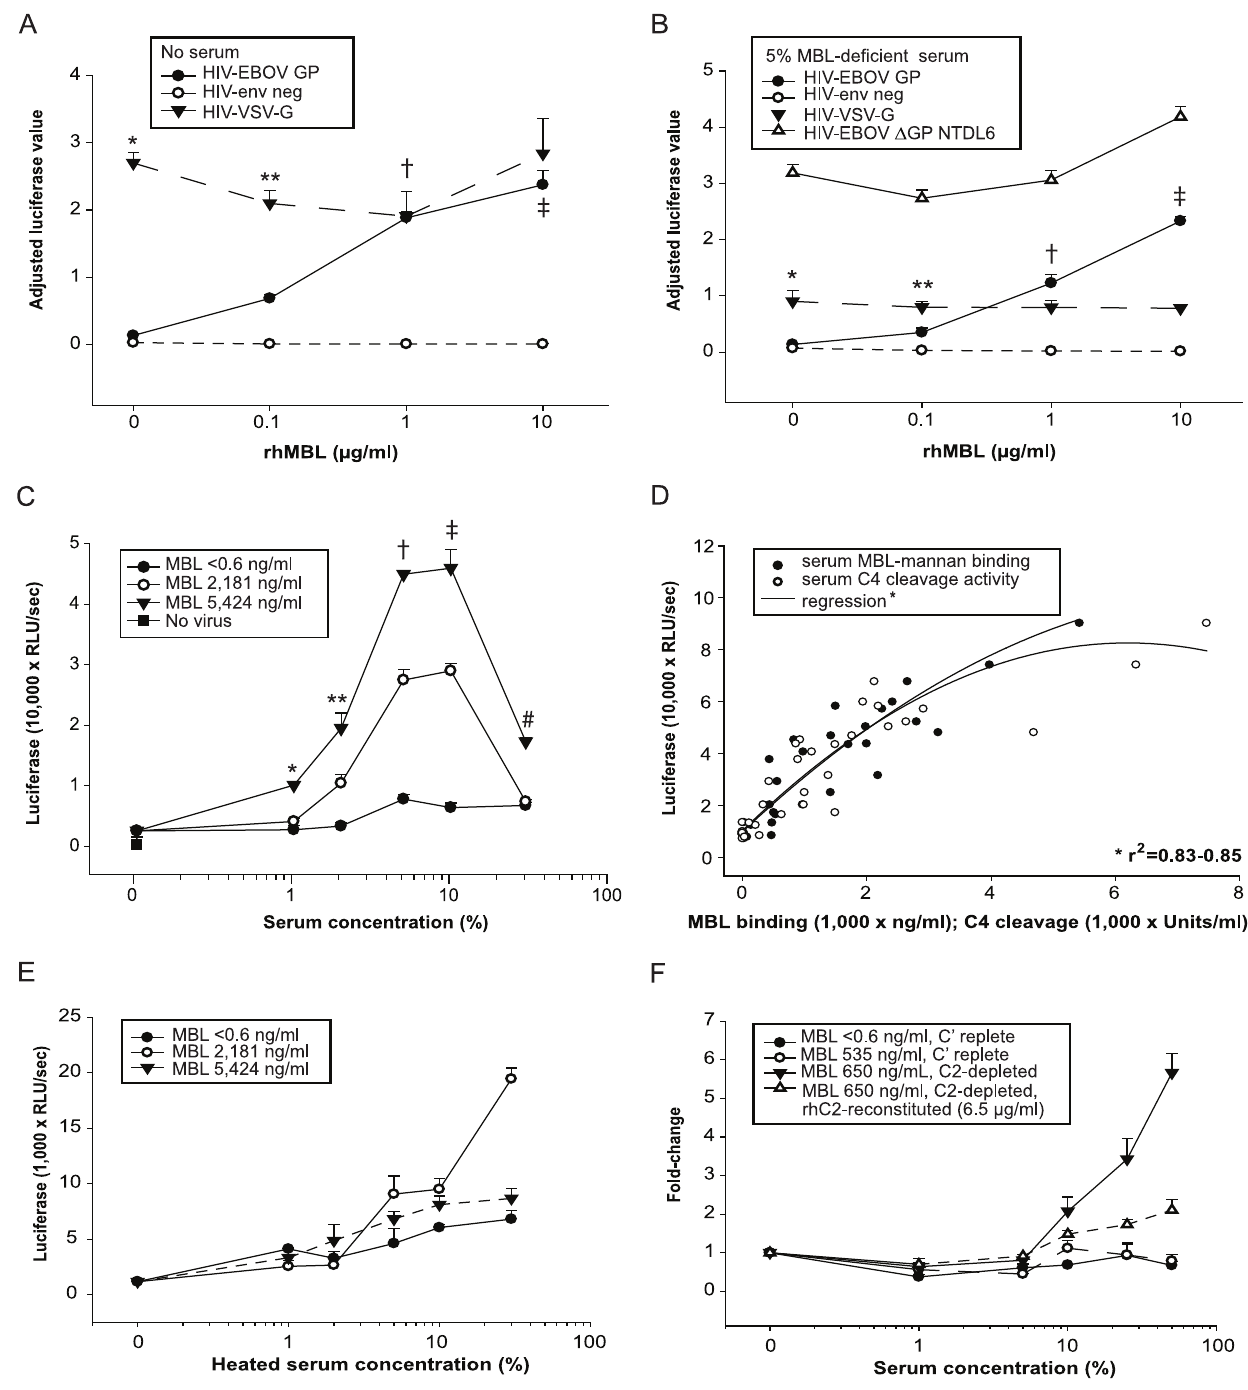
Figure 1. MBL enhances HIV-EBOV GP infection of HEK293F cells in low complement conditions. We used luciferase-encoding HIV-EBOV- GP virion-like particles to infect 5 6 10 3 adherent HEK293F cells. Viruses (350 pg p24/100 m l) were preincubated with physiological concentrations of rhMBL (0.1–10 m g/ml) in (A) DMEM or (B) MBL-deficient ( , 0.6 ng/ml) 5% human serum for 1 hour at 37 u C. We analyzed infection rates after 40 hours. Luciferase absorbance values were adjusted for cell viability by normalizing to alamarBlue fluorescence units (resazurin reduction assay) and results are expressed as Adjusted Luciferase Values. Significant differences are shown. * and ** p , 0.05 (HIV-VSV-G vs both other virions at 0 and 0.1 m g/ml supplemental rhMBL, respectively), { and { p , 0.05 (HIV- envelope negative vs both other virions at 1 and 10 m g/ml supplemental rhMBL, respectively). Also shown in (B) is the reduced capacity of rhMBL to enhance infection by HIV-EBOV- D GP NTDL6 (mutated GP lacks 217 amino acids in the heavily glycosylated mucin-rich region) compared with that for HIV-EBOV GP, which contains intact mucin-rich regions (1.3- vs 17.2 2 fold enhancement, respectively, p , 0.001). Experiments were performed twice in quadruplicate. (C) We preincubated HIV-EBOV GP with serial dilutions of serum from three individuals with undetectable ( , 0.6 ng/ml; LYPB/LYPB), intermediate (2,181 ng/ml; LYPA/HYPD) or high (5,424 ng/ml; HYPA/LYQA) MBL concentrations. Shown are luciferase values. * p , 0.05 (high level MBL v s low or intermediate level MBL at 1% serum dilution), **, { and { p , 0.05 (all pairwise comparisons at 2%, 5% and 10% serum dilutions, respectively), # p , 0.05 (all pairwise comparisons at 30% serum dilution). Experiments